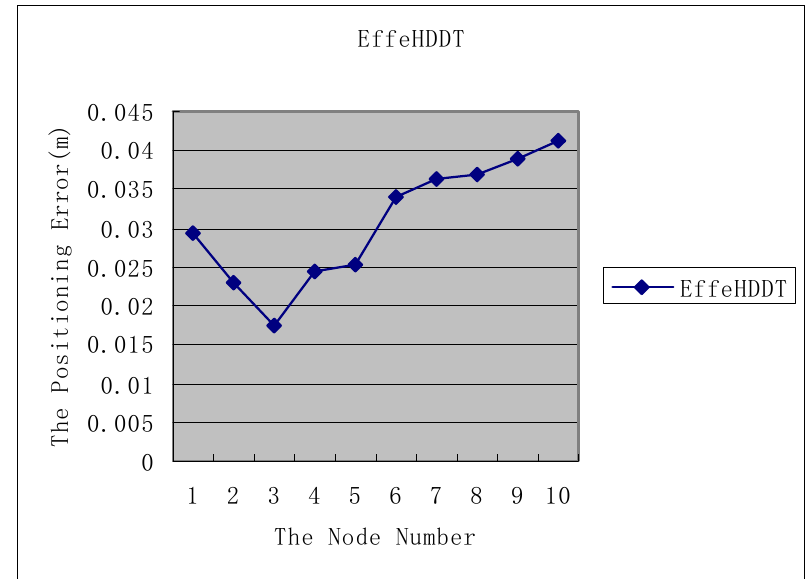
Figure 9. The positioning error of EffeHDDT.